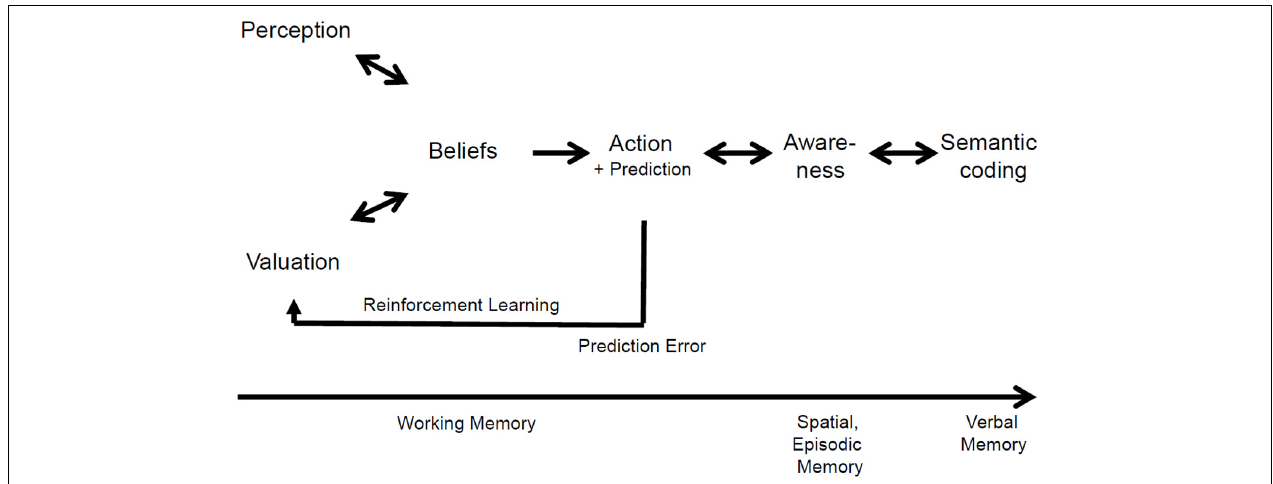
FIGURE 1 | Schematic representation of a RL process in the context of credition. Source: Seitz et al. (in press), reproduced with permission.